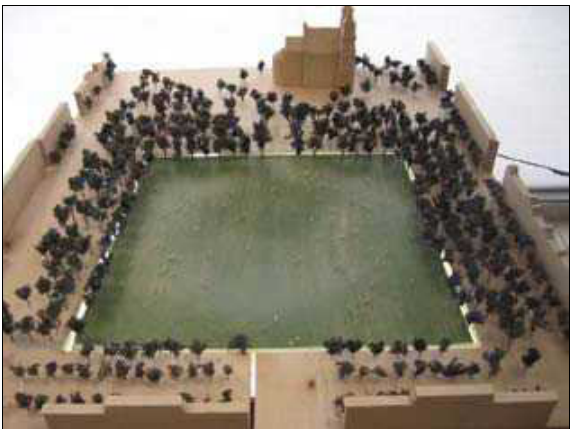
Fig. 10. Lukiškės Square reconstruction competition.